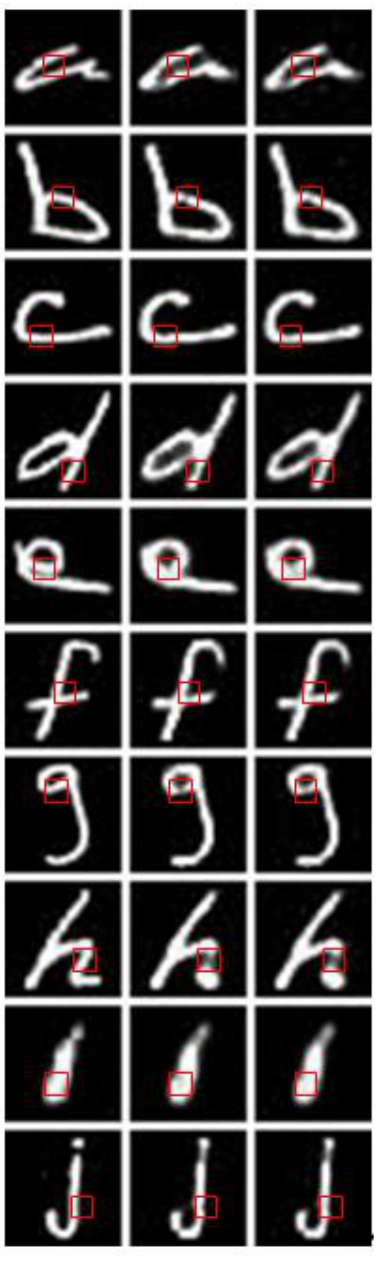
Figure 21. Marked reconstruction images on the EMNIST data set ( small letters ).